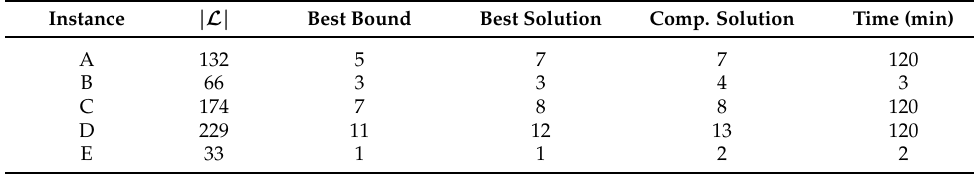
Table 5. Fourth run for all instances.